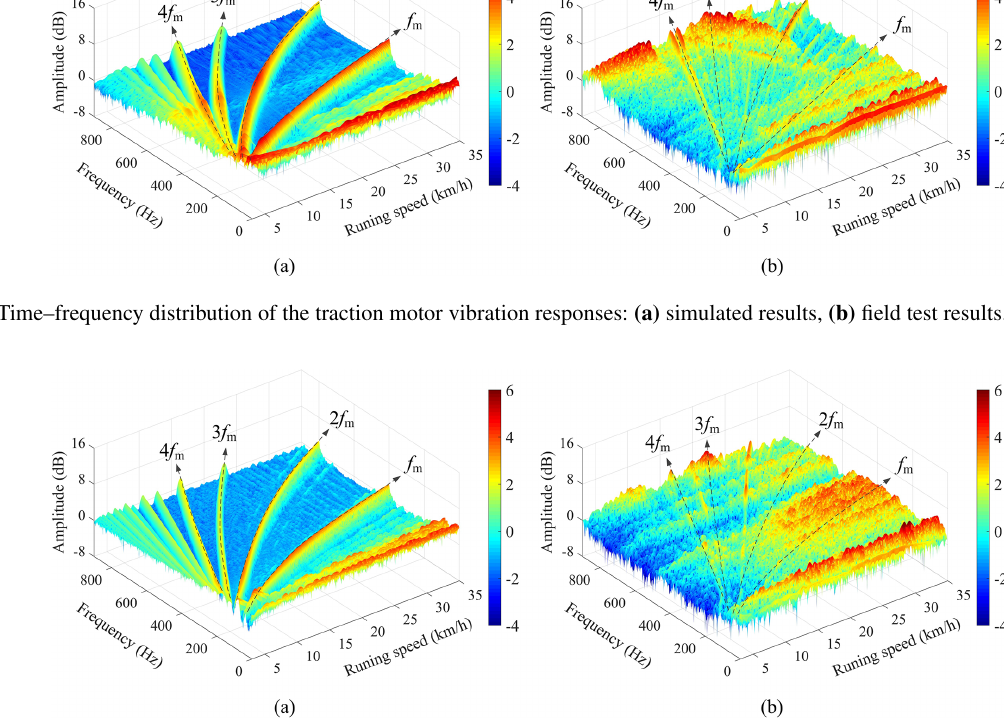
Figure 10. Time–frequency distribution of the wheelset vibration responses: (a) simulated results, (b) field test results.